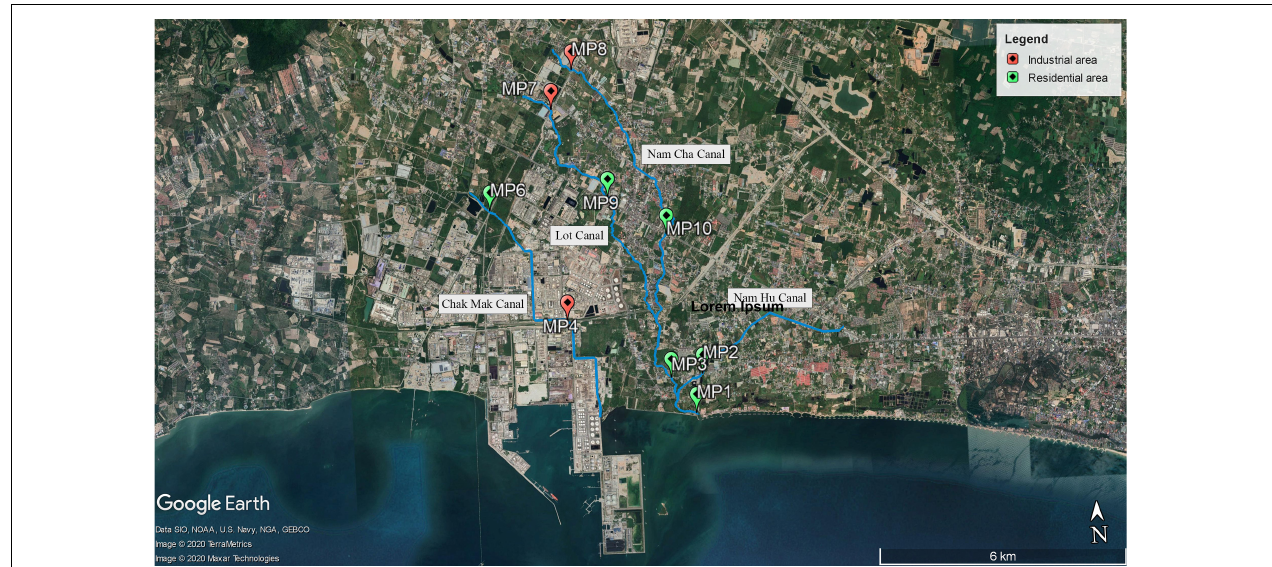
FIGURE 1 | Map of sampling